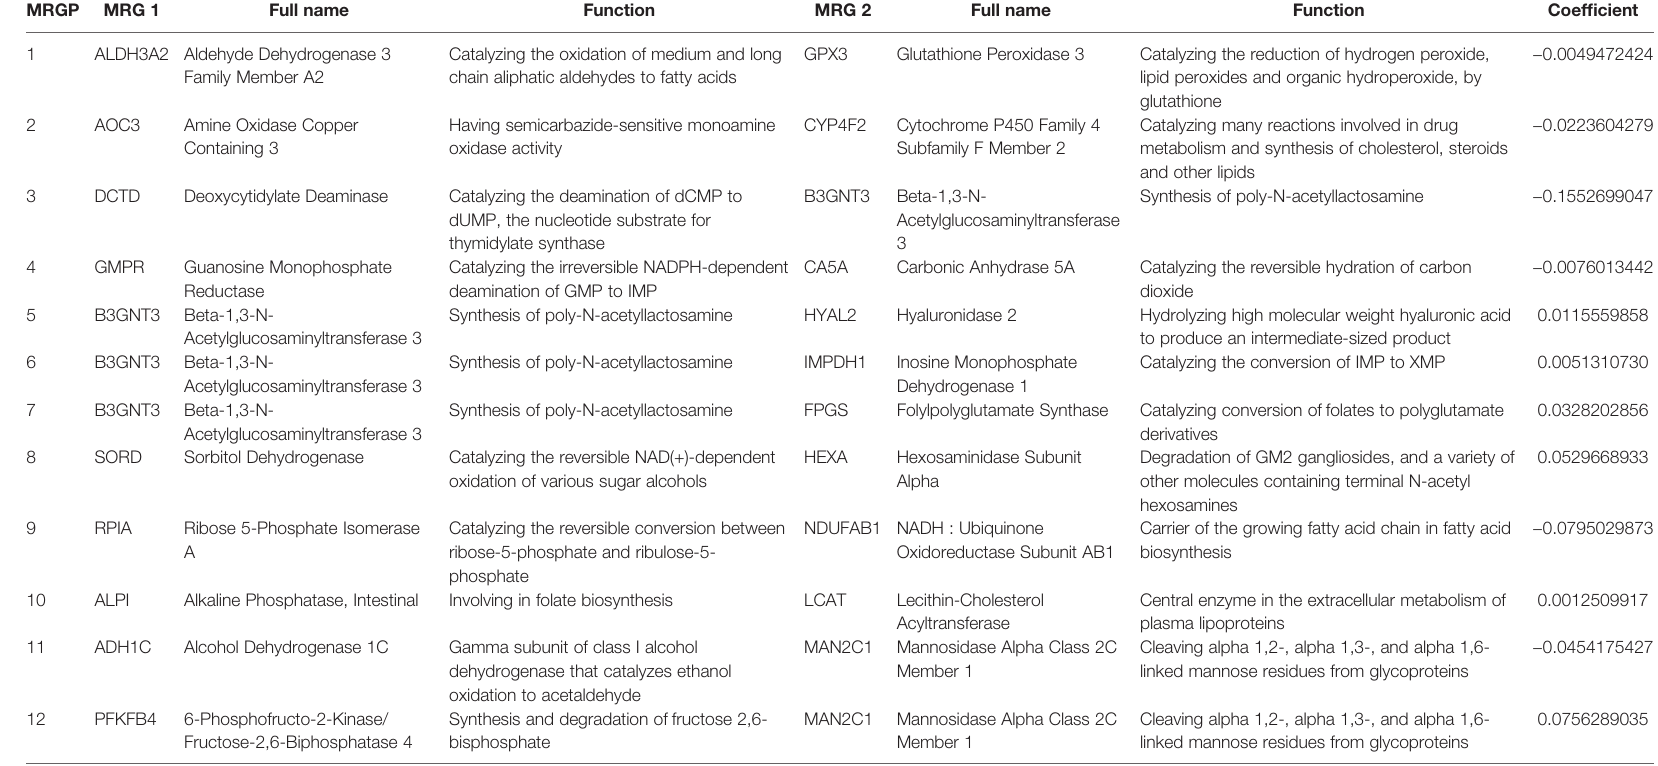
TABLE 2 | Model information about